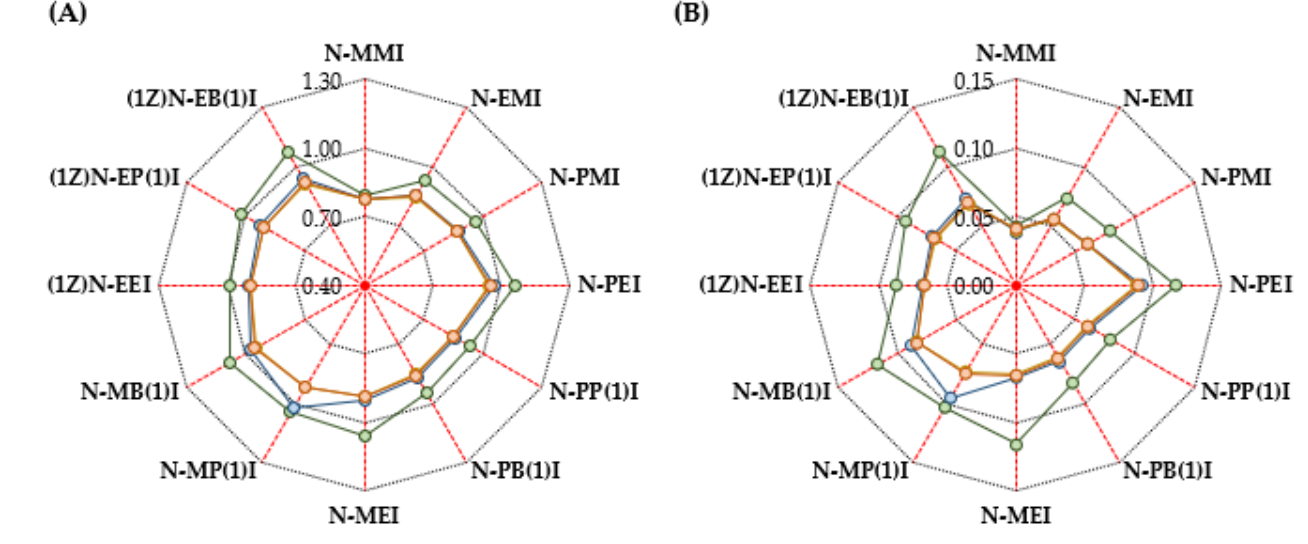
Figure 10. Initial Fe ( A )/Cu ( B )— studied Schiff bases interaction energy (Δψ ).